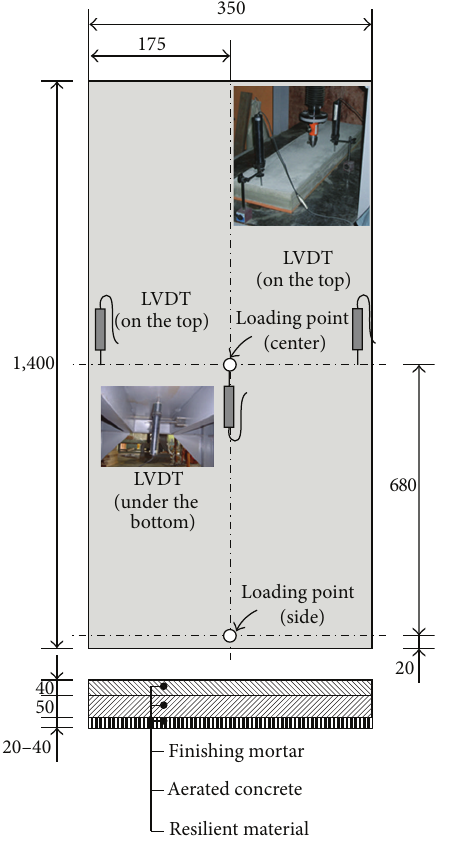
Figure 3: Dimensions and measurement of the floating floor